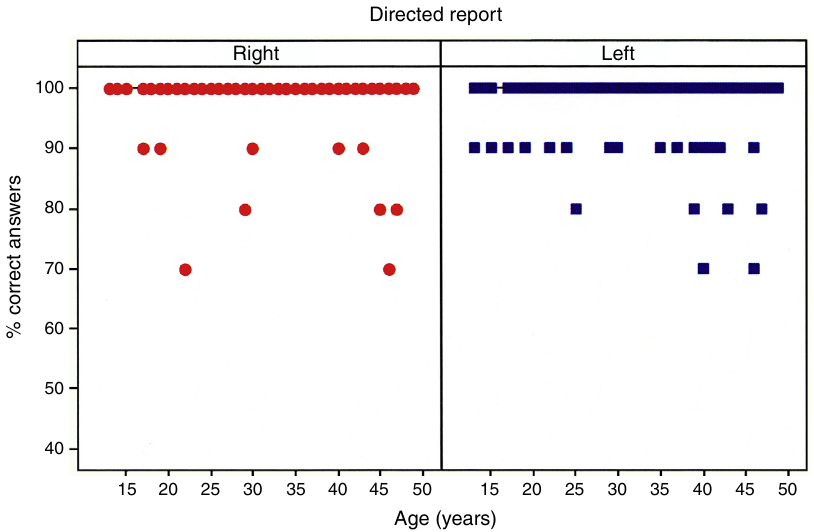
Figure 3 Scatter plots of correct answer percentages in the directed report stage by age and ear.